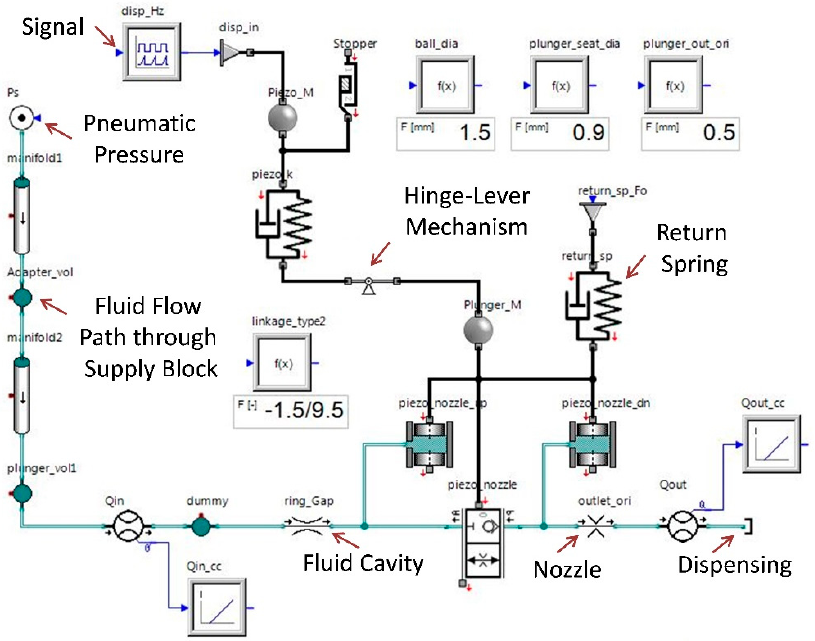
Figure 3. Geometry based modelling of the jet dispenser with a detailed simulation model representation of jet dispenser on SimulationX. Table 2. Parameters and their values used in the simulation.